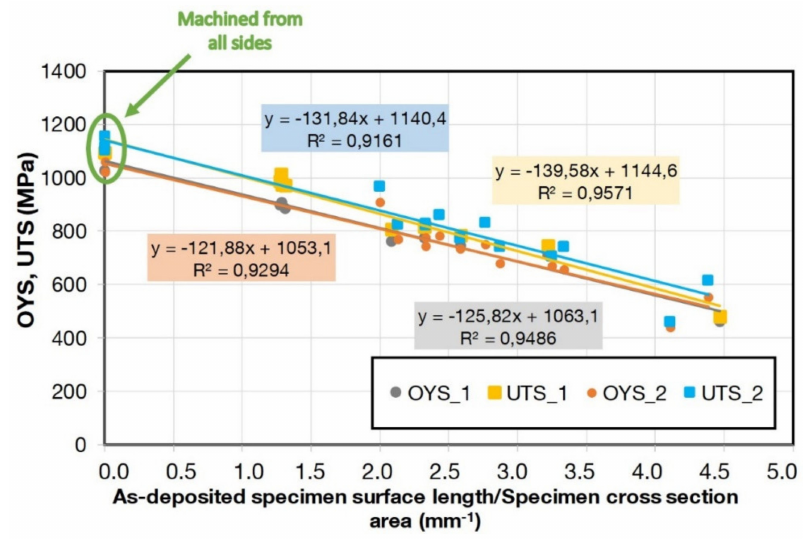
Figure 16. Dependence of OYS and UTS values on specimen surface length / cross section ratio for EBM-processed flat specimens from the first (“1”) and second (“2”) batch of